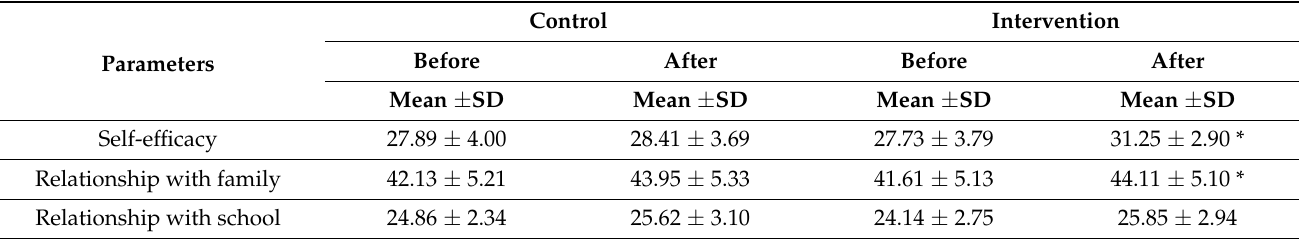
Table 4. Comparisons of self-efficacy and relationship with family and school activities between the intervention and control